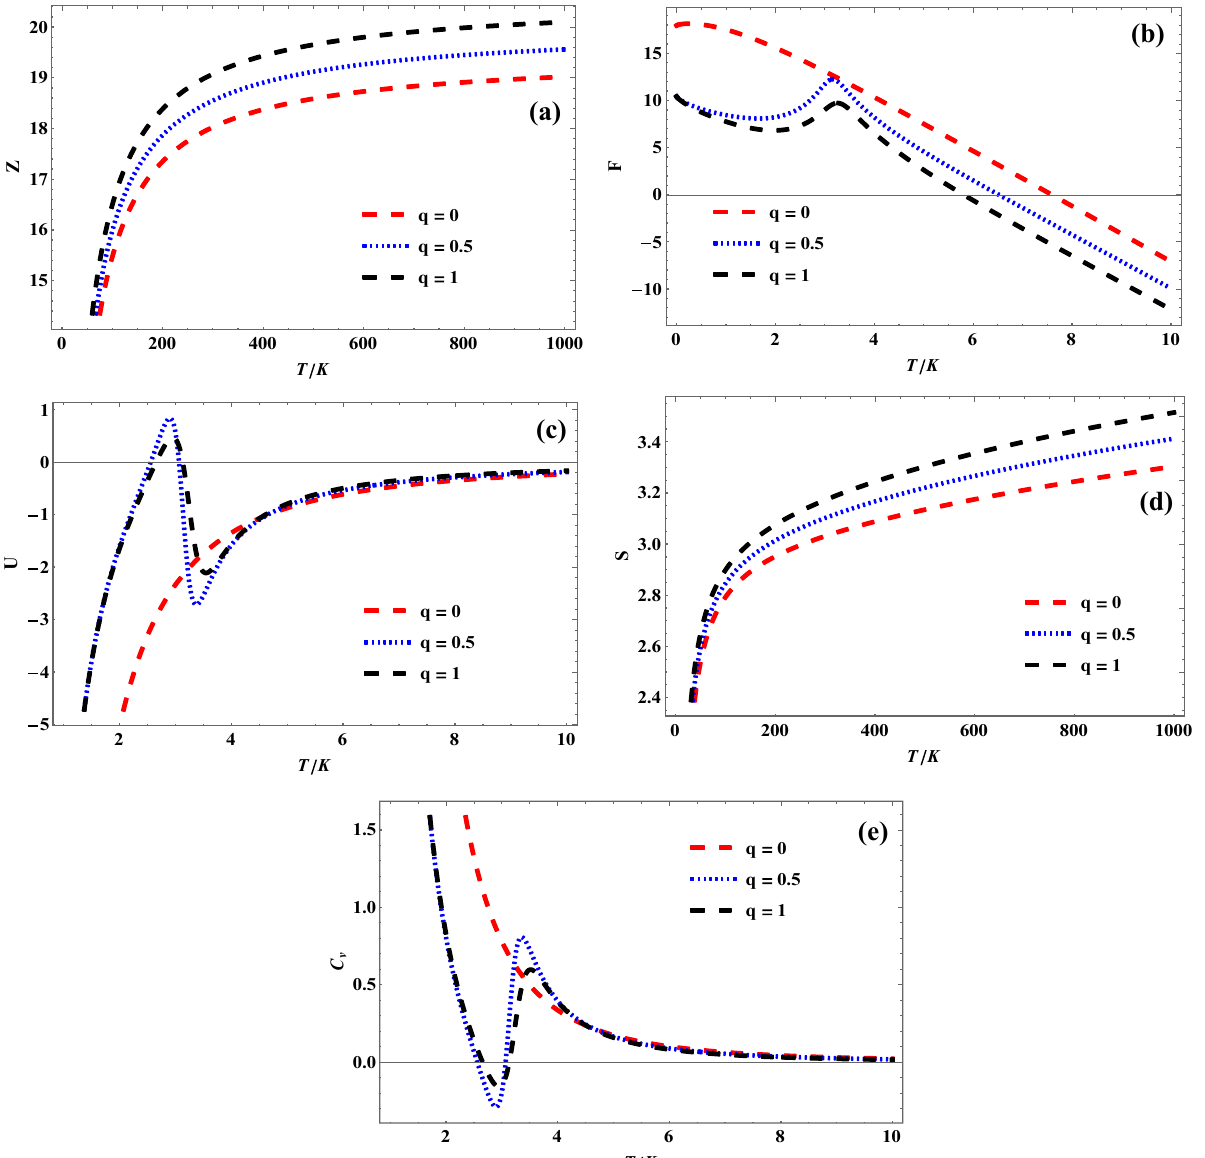
Figure 5. ( a ) Variation of partition function of quantum pseudoharmonic oscillator with temperature for selected q -values with κ =− 1. ( b ) Variation of free energy of quantum pseudoharmonic oscillator with temperature for selected q -values with κ = − 1. ( c ) Variation of internal energy of quantum pseudoharmonic oscillator with temperature for selected q -values with κ = − 1. ( d ) Variation of entropy of quantum pseudoharmonic oscillator with temperature for selected q -values with κ = − 1. ( e ) Variation of specific heat capacity of quantum pseudoharmonic oscillator with temperature for selected q -values with κ = −